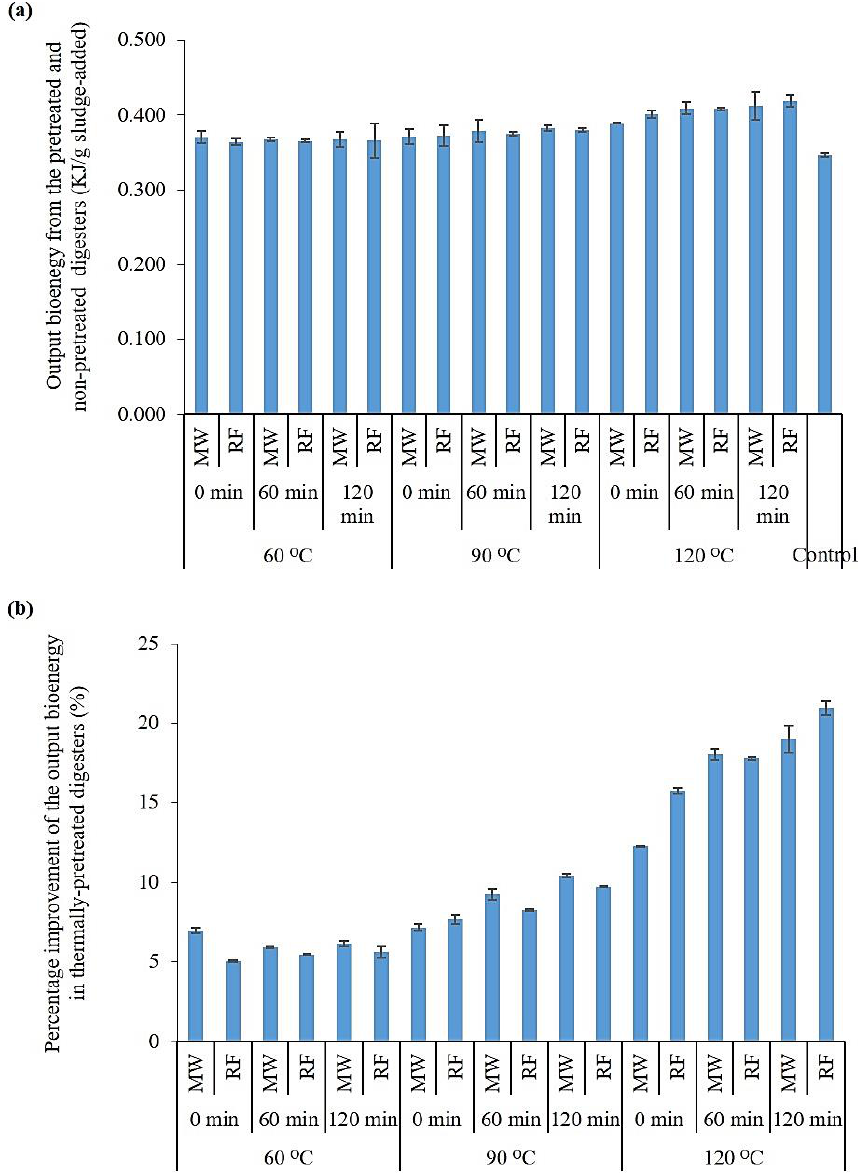
Figure 3. ( a ) Output energy from the pretreated and non-pretreated digesters; ( b ) percentage improvement (relative to the control digester) in output energy.